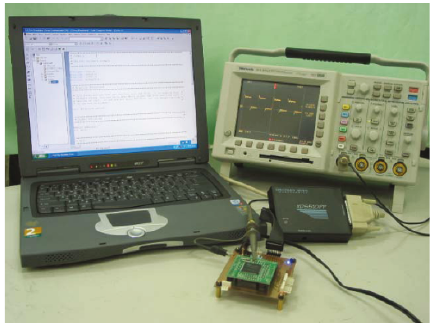
Figure 3: Laboratory workstation based on the self-developed DSP platform, which also shows PC, JTAG emulator and